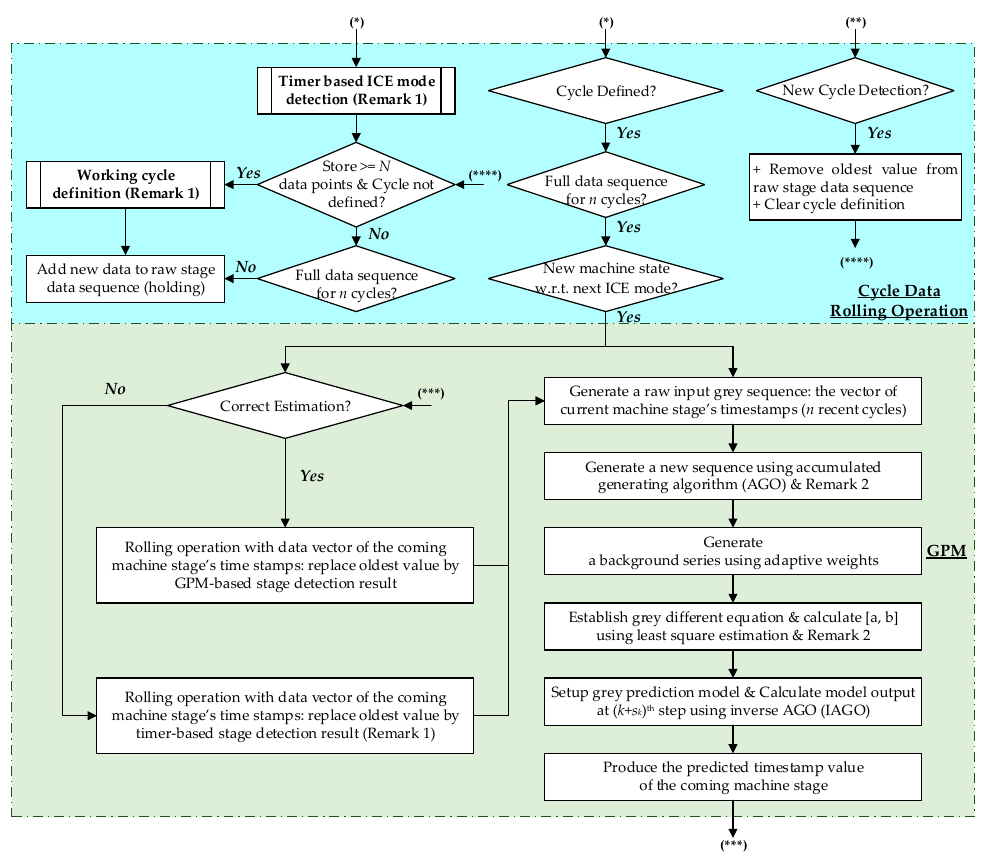
Figure 6. Flow diagram of the cycle data rolling operation and GPM modules.